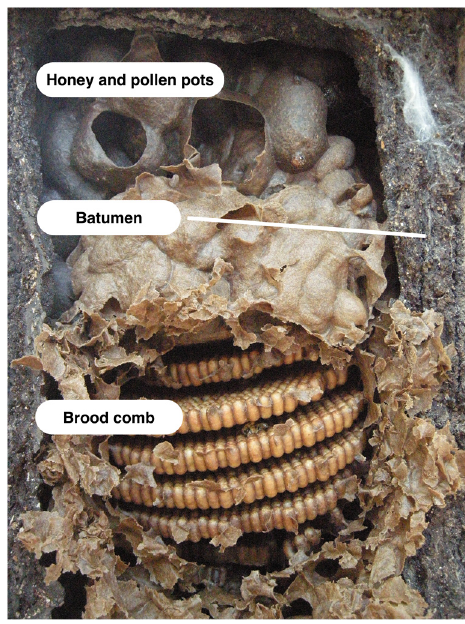
Figure 1. Nest structures such as brood comb and honey and pollen pots are made of cerumen, a mixture of wax and resin. The batumen is a wall-like structure that surrounds and protects stingless bee nests; it is often made of resin. Photo by Miguel Angel Guzmán Díaz.